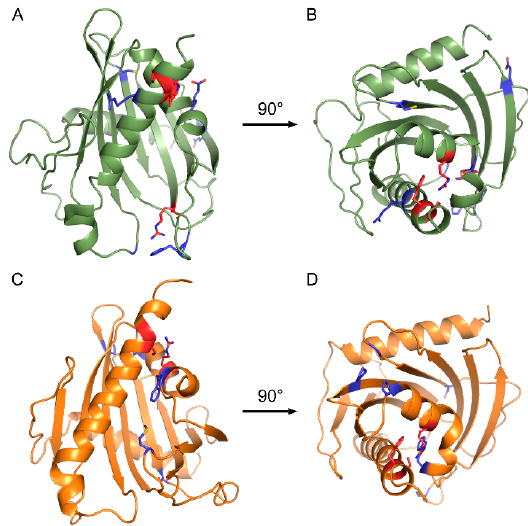
Figure 4. Homology models of DLC-1 and DLC-2 START domains. ( A , C ) Side and ( B , D ) top-down views of ( A , B ) DLC-1 (green) and ( C , D ) DLC-2 (orange) START domains. Blue indicates conserved residues with missense mutations in cancers. Red indicates conserved arginine, serine, and phenylalanine residues mutated in both DLC-1 and DLC-2, as well as the highly-conserved arginine in DLC-1 (R988) mutated in numerous